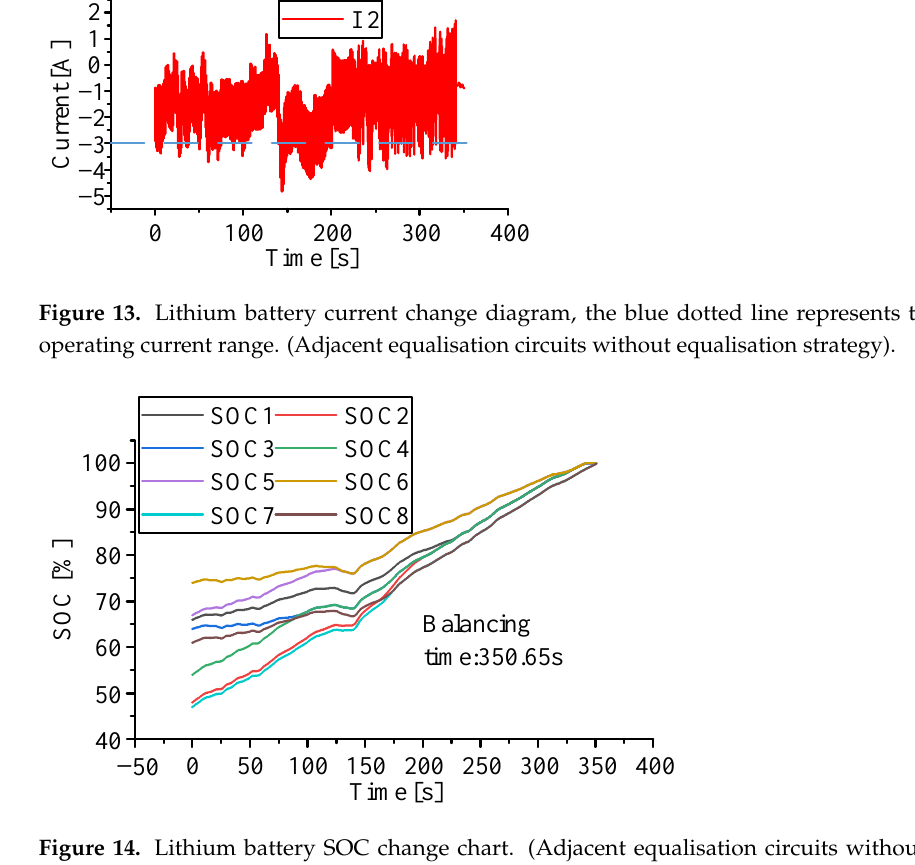
Figure 14. Lithium battery SOC change chart. (Adjacent equalisation circuits without equalisation strategy).